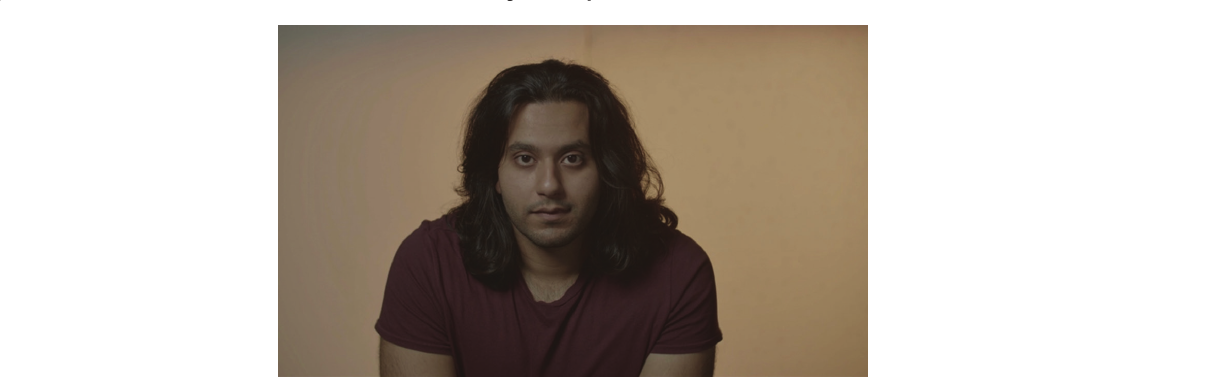
Figure 11. Medium shot with cheerful mood by Group 2 (Source: Author, 2022)